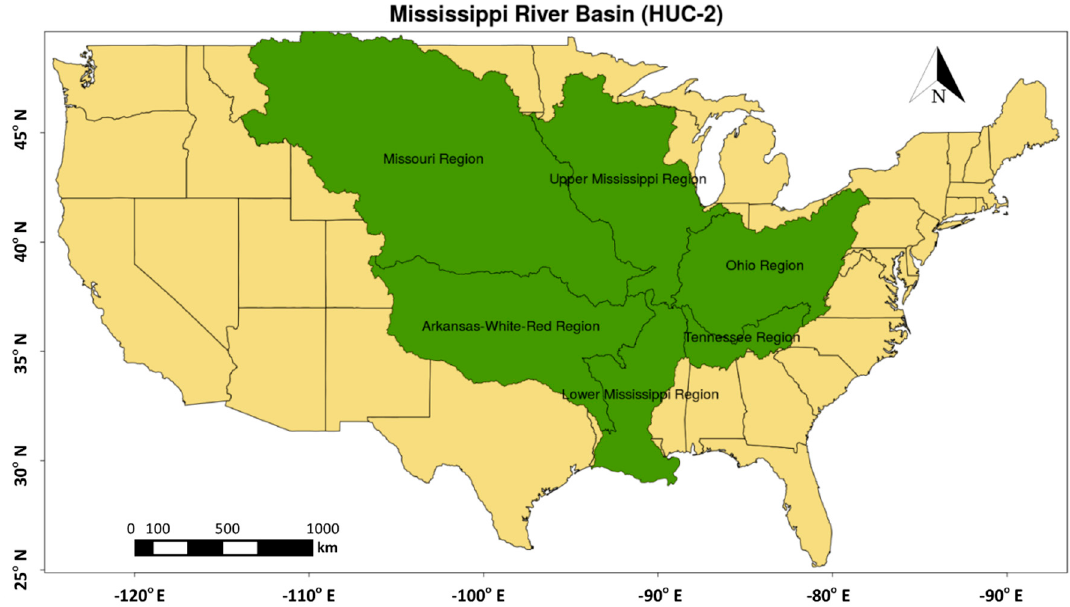
Figure 1. A map of the Mississippi basin showing the six USGS Hydrologic Unit Code (HUC)-2 basins.